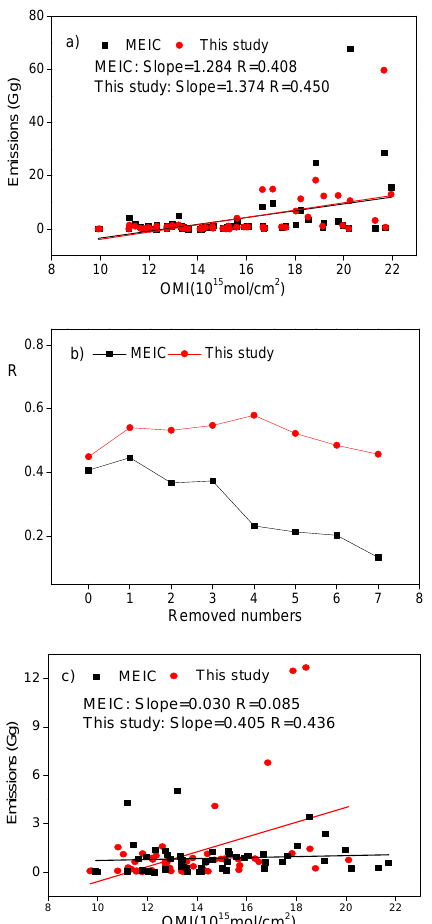
Figure 6. Spatial correlation between NO x emissions from city- and national-scale inventories and NO 2 vertical column density (VCD) from OMI, in Nanjing, 2010 for (a) all grids, (b) step-wise exclu- sion of grid cells with largest emissions, and (c) grid cells without power plant emissions.